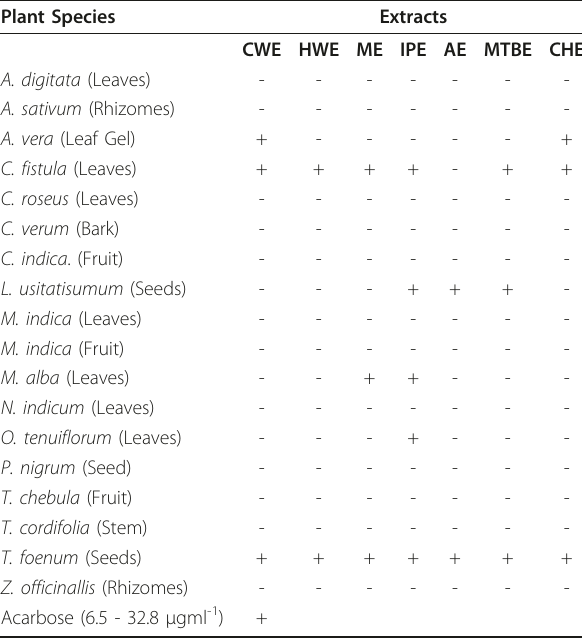
Table 2 Inhibition of PPA activity based on starch-iodine color assay by solvent extracts a of different plants